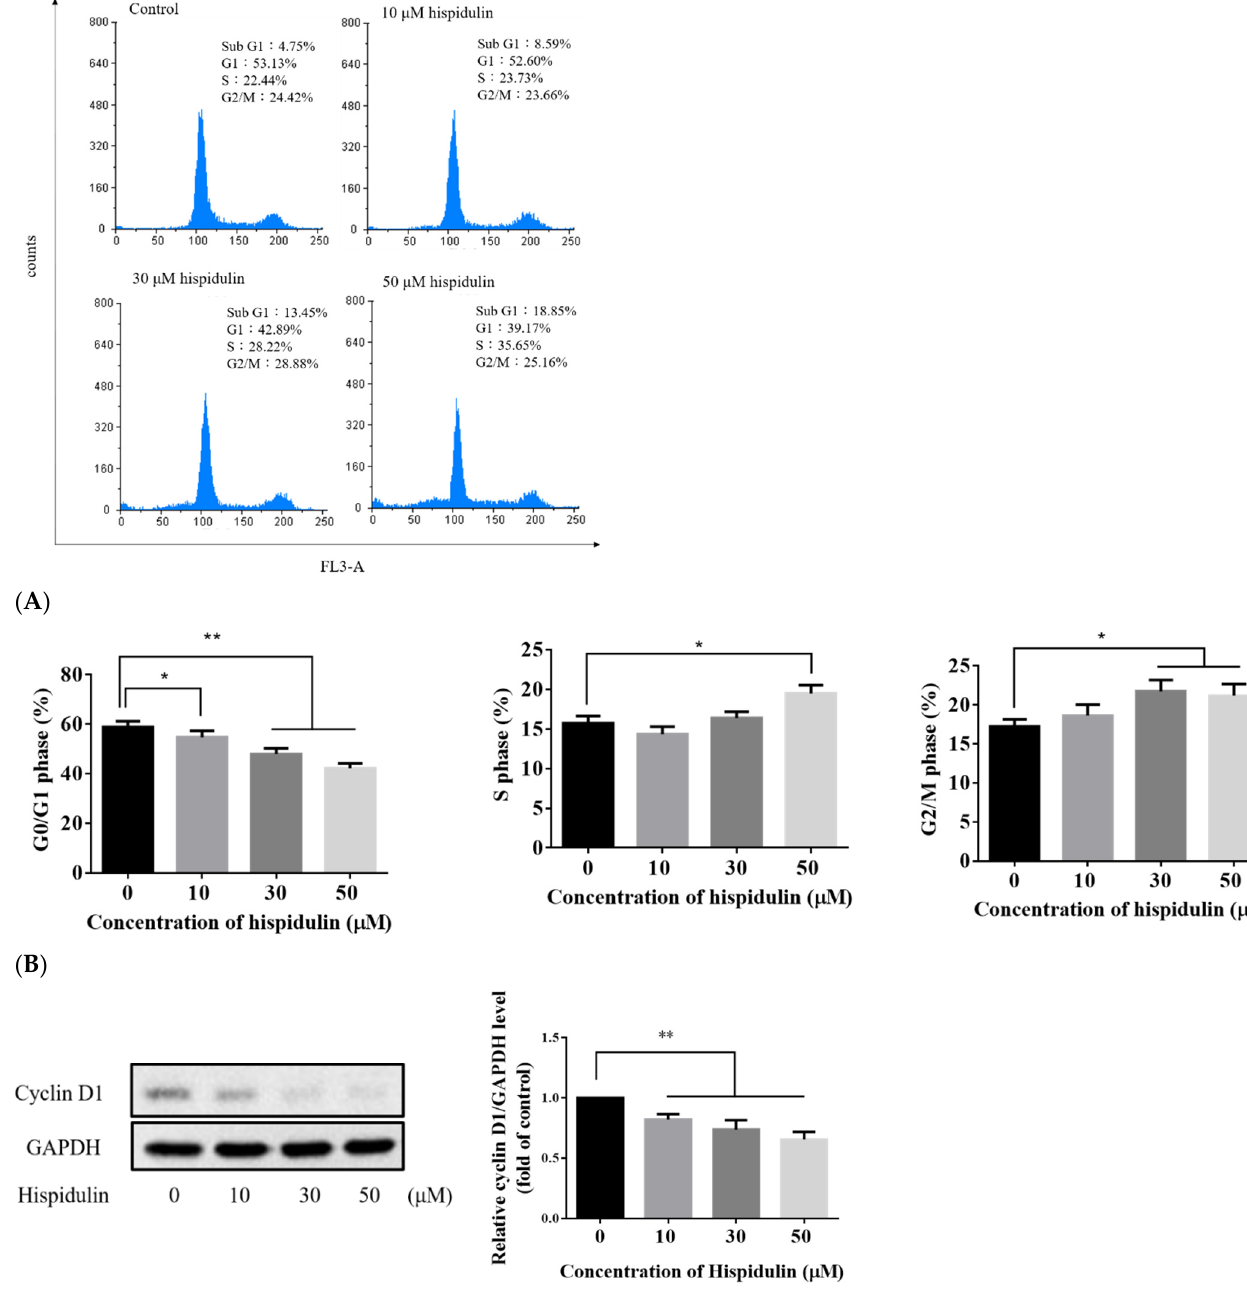
Figure 2. ( A ) Effect of hispidulin on the cell cycle in A2058 cells. A2058 cells were incubated with various concentrations (0, 10, 30, and 50 µM) of hispidulin for 24 h followed by staining with PI for flow cytometric analysis to determine cell cycle distribution. Results reveal the number of cells/channel ( y -axis) versus DNA content ( x -axis). The values shown present the percentage of cells in the indicated phases of the cell cycle and the cell distribution in different phases of the cell cycle. ( B ) Statistical analysis of hispidulin-treated A2058 cell cycle distribution. ( C ) Effect of hispidulin on cell cycle-related protein in A2058 cells. Expression levels of cyclin D1 in A2058 cells treated with hispidulin (0, 10, 30, and 50 µM) for 24 h were examined by Western blot assay. GAPDH was used as an internal control. Data were presented as fold of control and mean ± SE. * p < 0.05 and ** p < 0.01 compared with the untreated control group (n = 6).